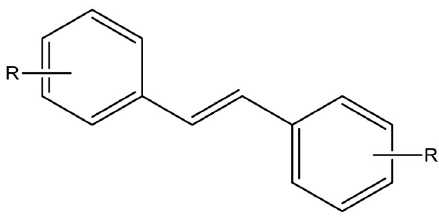
Figure 3. General chemical structure of resveratrol derivatives.